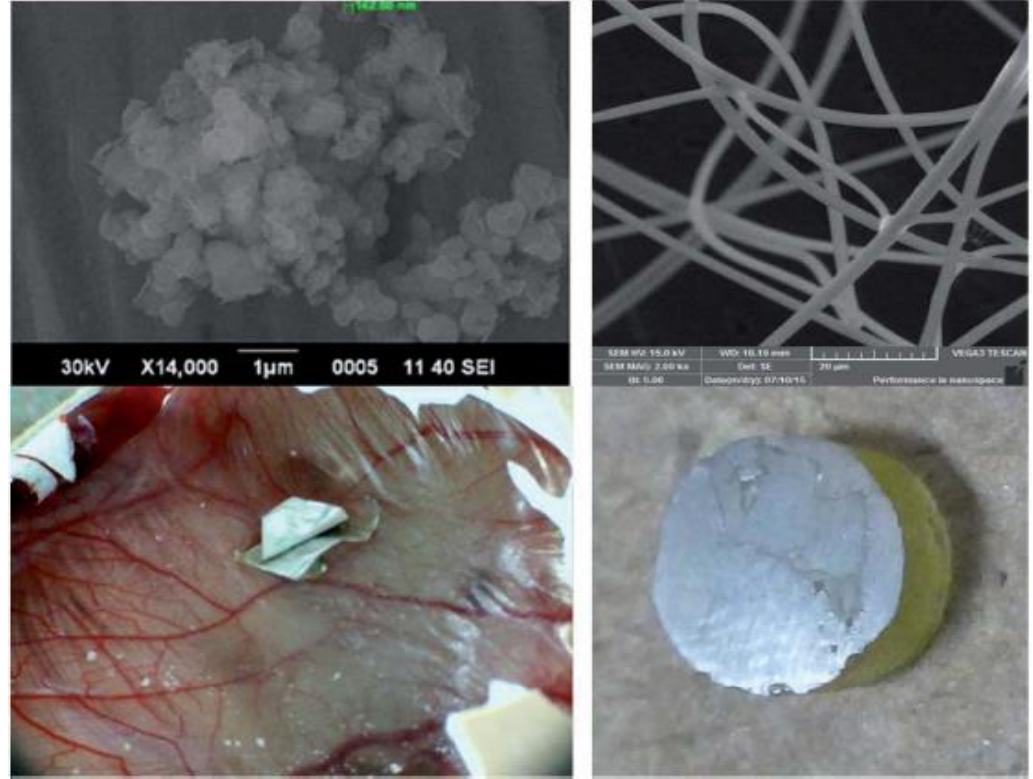
Figure 9. Electrospun hydroxyapatite/carbon nanotube fibers for biomedical/dental applications are manufactured and tested in vivo [95].